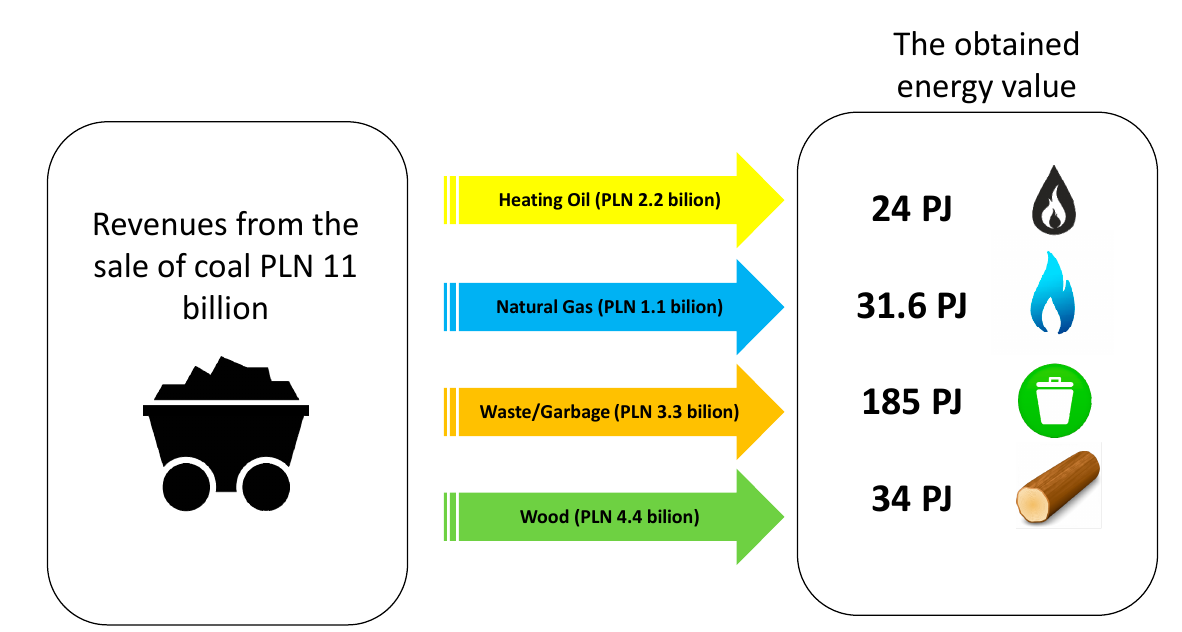
Figure 5. Scenario 7—energy value (PJ) of the assumed mix of alternative fuels (in PLN). Source: own study. Table 4. Estimation of the energy value for scenario 7.